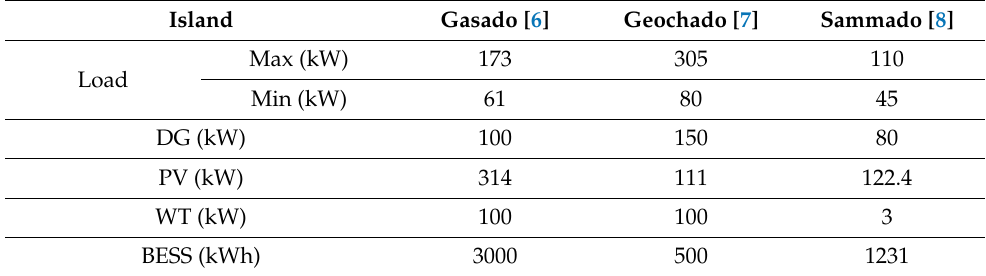
Table 1. Hybrid-type island microgrids in